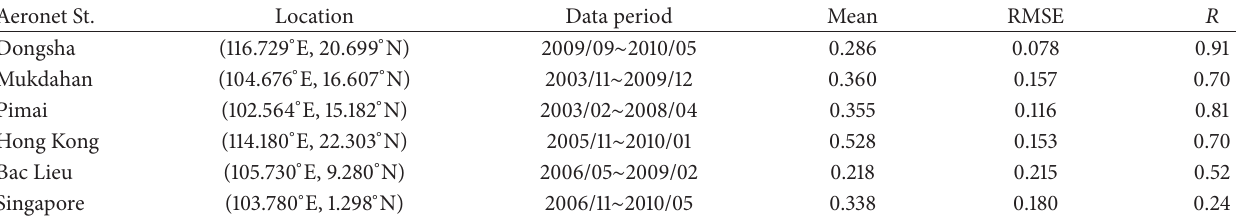
Table 1: The mean of Aeronet AOD, root-mean-square-error (RMSE), and correlation coefficient ( 𝑅 ) between monthly MODIS AOD and Aeronet AOD 500 nm.